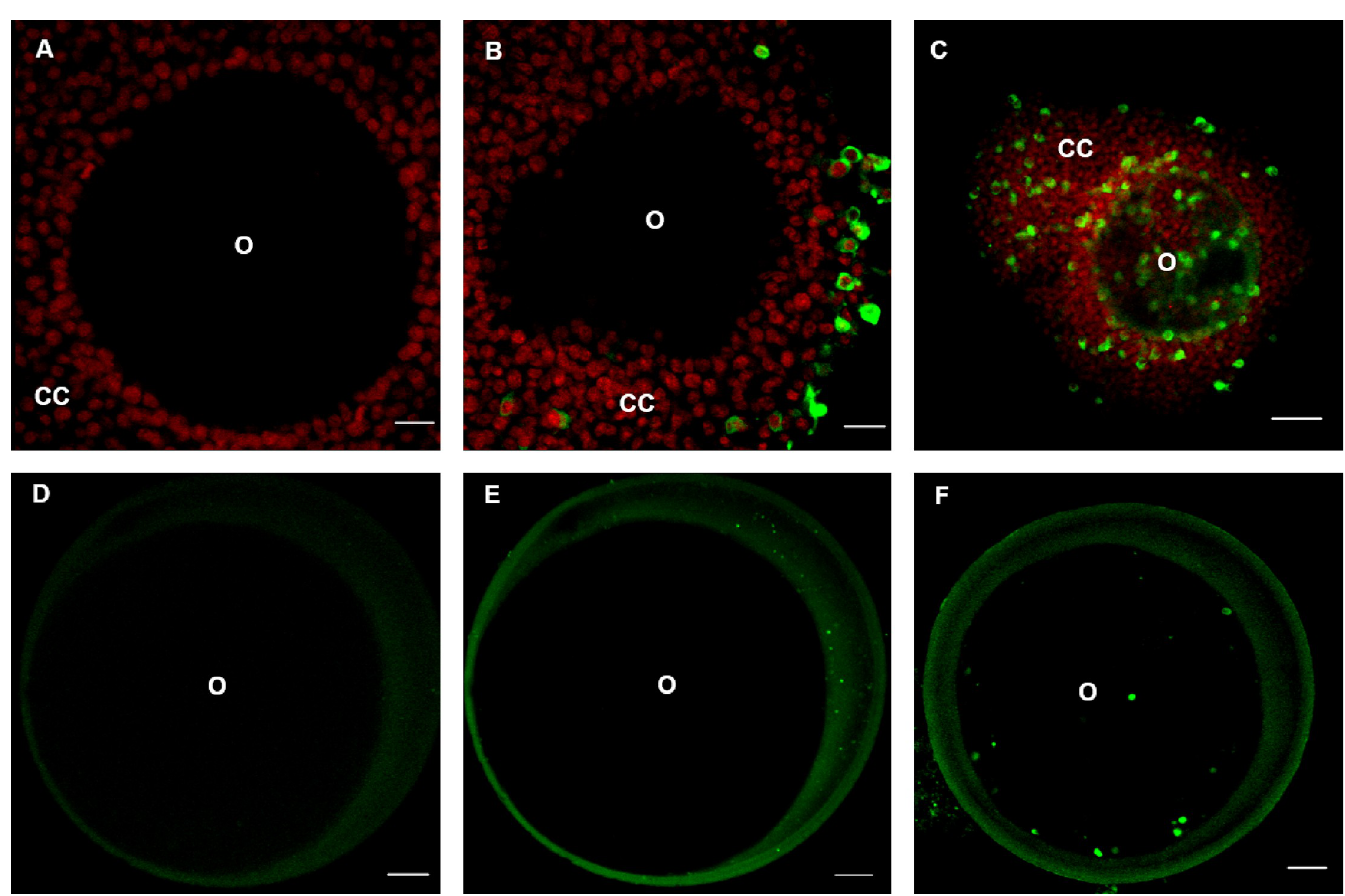
Fig 2. Images of COCs and denuded oocytes obtained by confocal laser scanning microscopy. Experimental infection of bovine oocytes with BHV1 incubated for one and 24 h. (A) confocal image of COC negative control, (B) immunolabelling of BHV1 (green) in the cytoplasm of cumulus cells (CC) of co-incubated COCs for 1 h (Scale bar = 20 μ m) and (C) immunolabelling of BHV1 in the cytoplasm of COC cumulus cells co-incubated for 24 h (Scale bar = 50 μ m). O: oocyte. The nuclei of the cumulus cells were stained with TO-PRO 3 iodide (red). (D) denuded oocyte control. (E) denuded oocyte co-incubated with BHV1 for 1 h and (F) denuded oocyte co- incubated with BHV1 for 24 h (Scale bar = 20 μ m).